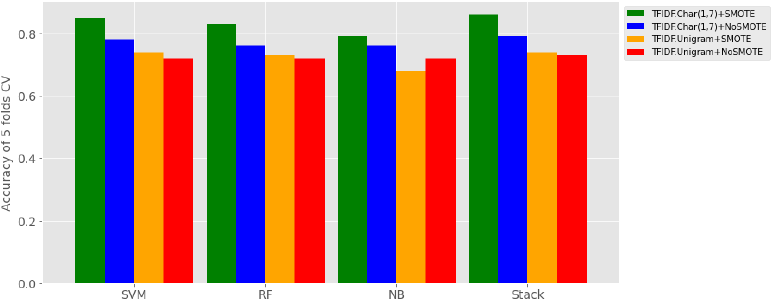
Figure 5. Comparison of the Performance of Proposed Stacking Sentiment Classifier with base Ma‑ chine Learning Classifier using all four Data